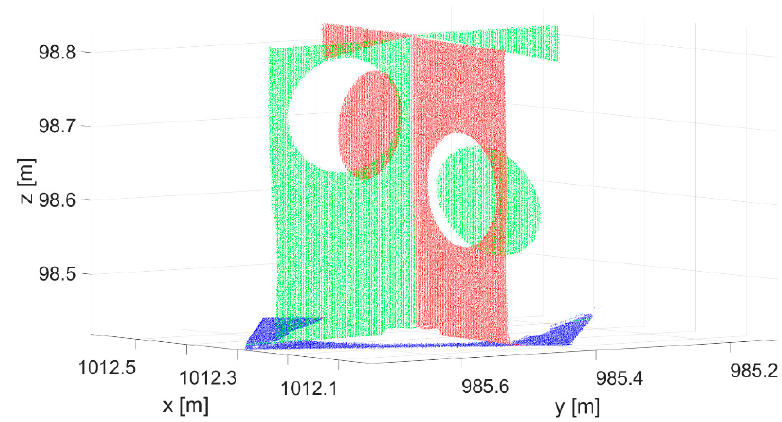
Figure 4. Segmented point cloud of the new target, following primary segmentation.